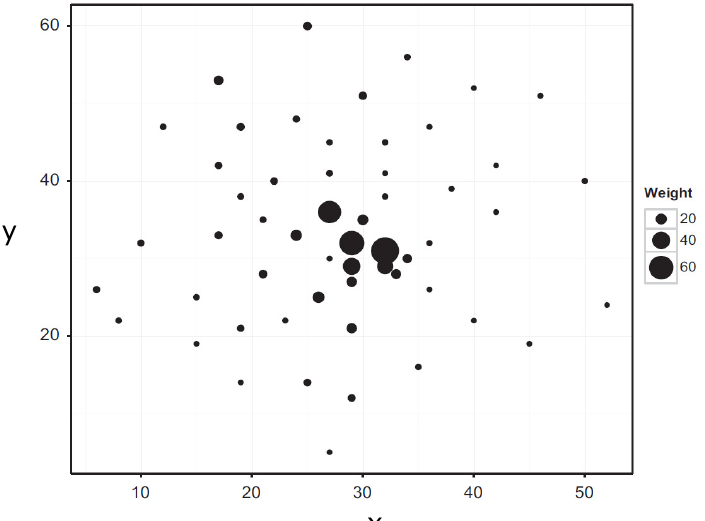
Figure 1. Swain’s data set is one of the most used sets in the literature and benchmarks.